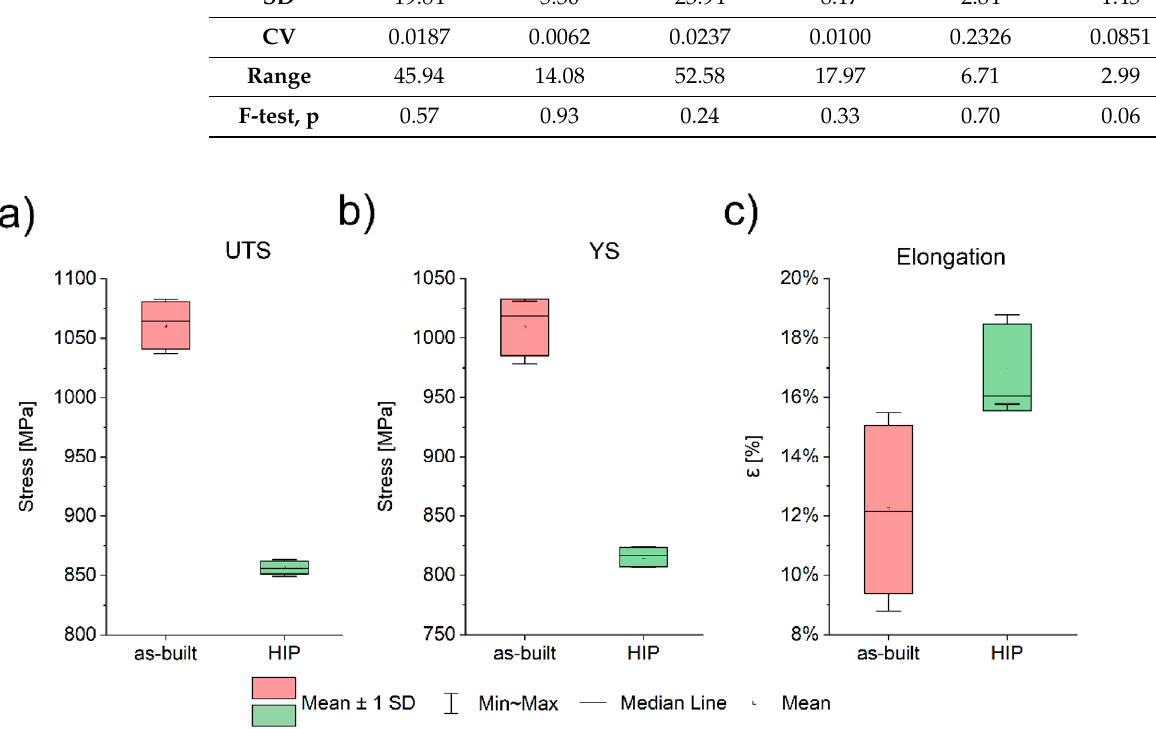
Figure 12. Tensile properties of the as-built and HIP state: ( a ) UTS, ( b ) YS, ( c ) elongation. The HIP specimens show a coefficient of variation about three times lower than the elongation values of the samples in the as-built state. W-testing (Shapiro–Wilk) was also performed for each measurement series to test the normality of the samples. For all the analyzed series, the obtained p -value of the test is greater than the assumed level of significance ( α = 0.05), which does not allow us to reject the hypothesis that the sample comes from a normal